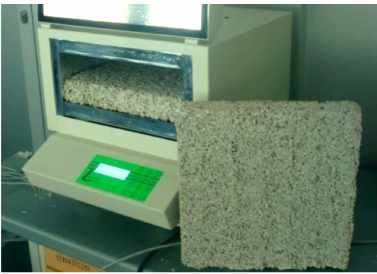
Figure 2. Heat flow meter—Fox 314 apparatus with the hemp–lime composite (Wall mix A)